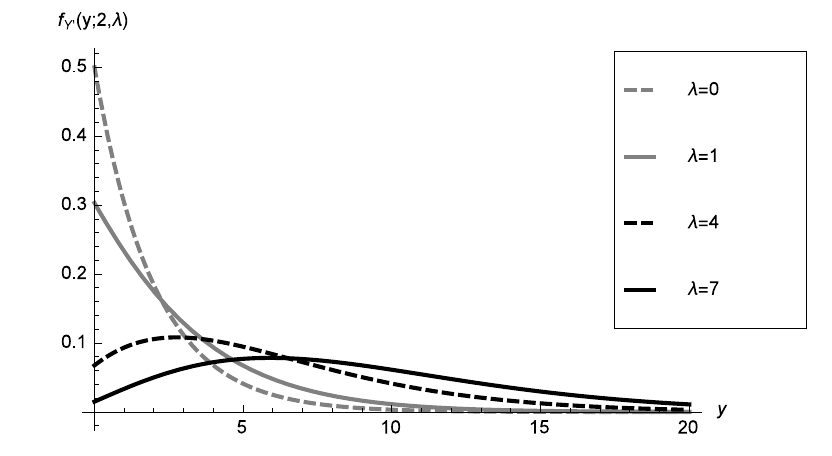
Figure 1 { Plots of the density of Y ′ (cid:24) (cid:31) ′ 2 g ( (cid:21) ) for g = 2 and selected values of (cid:21)